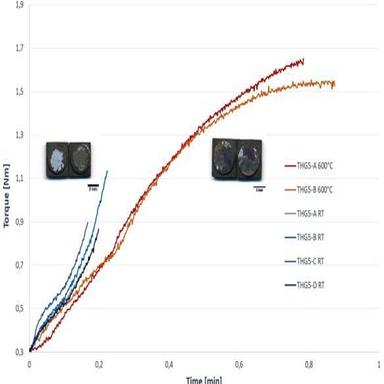
Typical torque (T, N/m) versus time (minutes, 4°/min) of THG-5 samples joined by GC1, showing the brittle behavior of the glass-ceramic joining material at room temperature (curves A-D, RT), with the typical fracture surfaces after torsion, (inset). Curves A-B 600 °C refer to THG-5 joined samples tested at 600 °C: the elasto-plastic behavior is evident, with the typical fracture surfaces after torsion, (inset).